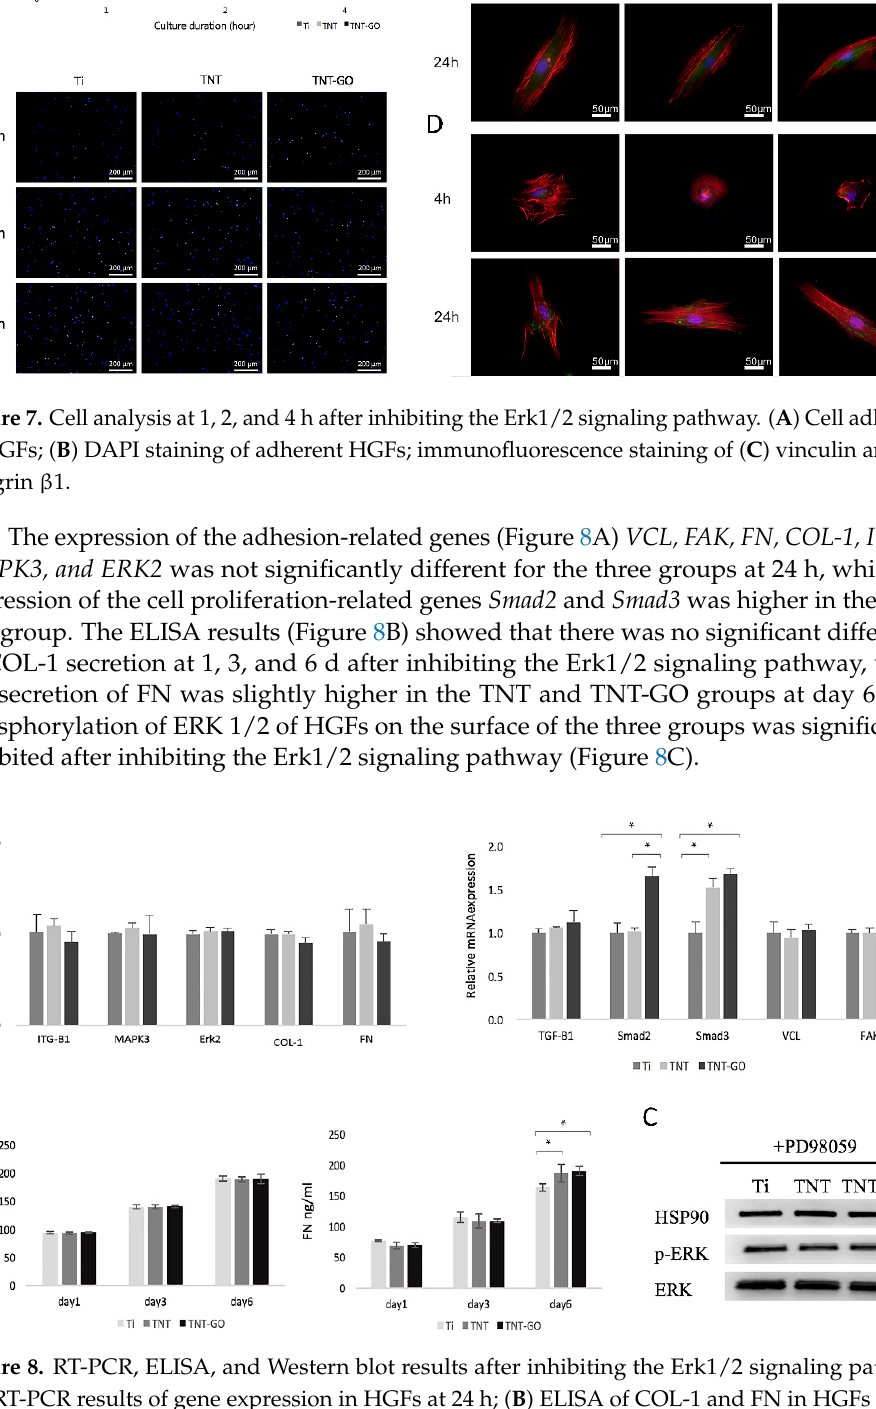
Figure 8. RT-PCR, ELISA, and Western blot results after inhibiting the Erk1/2 signaling pathway. ( A ) RT-PCR results of gene expression in HGFs at 24 h; ( B ) ELISA of COL-1 and FN in HGFs at 1, 3, and 6 d; ( C ) Western blot results of ERK and p-ERK at 24 h (* p < 0.05).